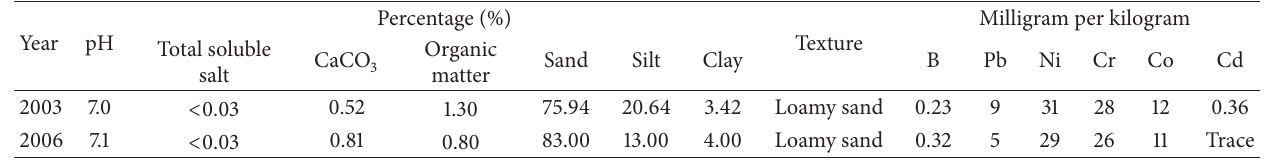
Table 2: Physical and chemical properties of the two experimental soils (0–20cm